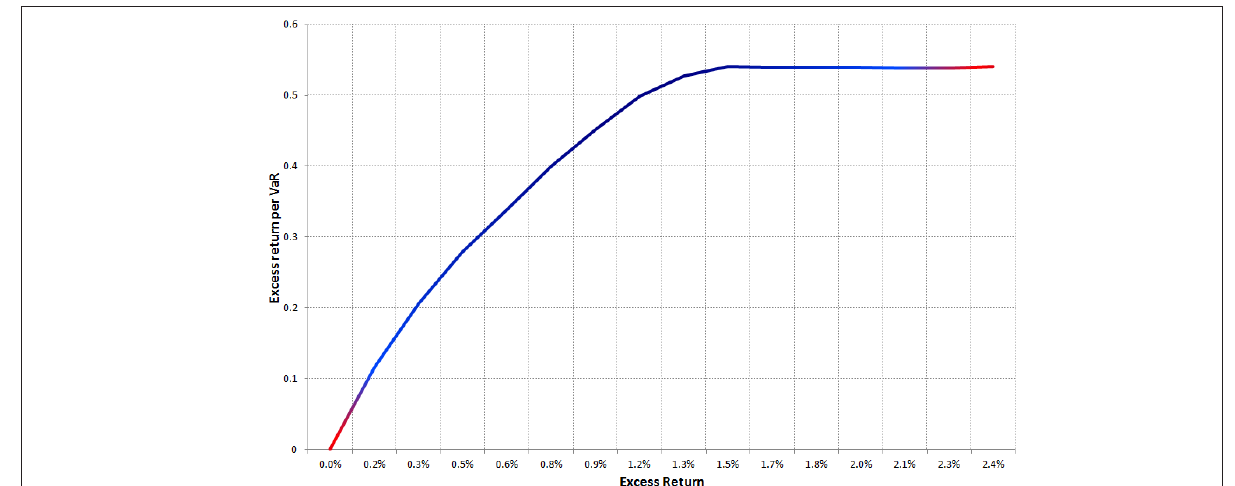
Figure 3: Excess return per unit of VaR (98% confidence